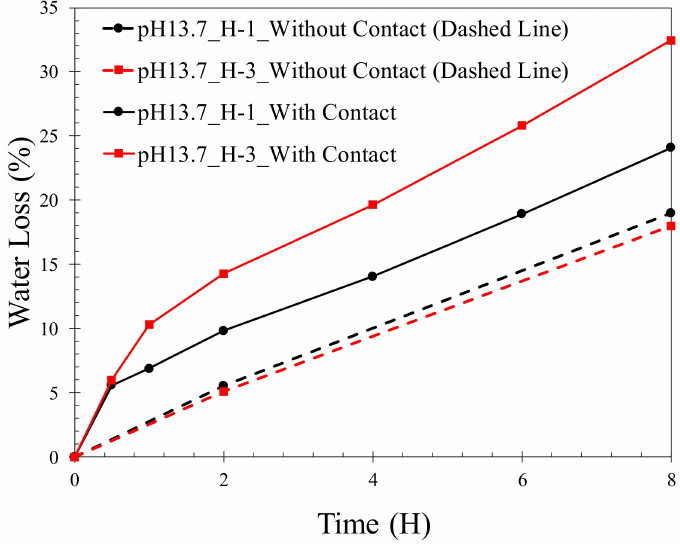
Figure 5. Desorption of H-1 and H-3 hydrogel disks with contact and without contact (control) with a cement paste